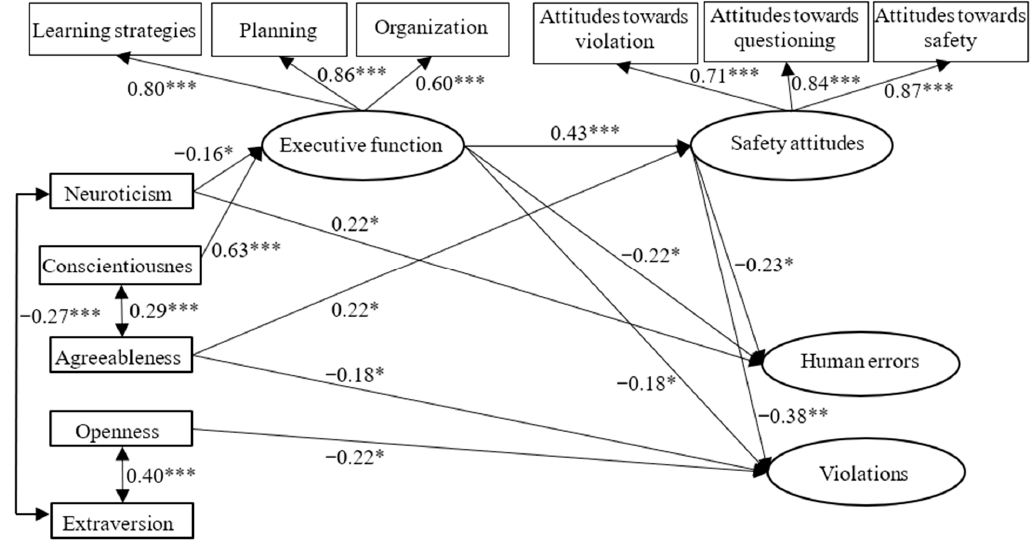
Figure 2. Results for the final model with significant structural relationships. * p < 0.05; ** p < 0.01; *** p < 0.001. *** p <